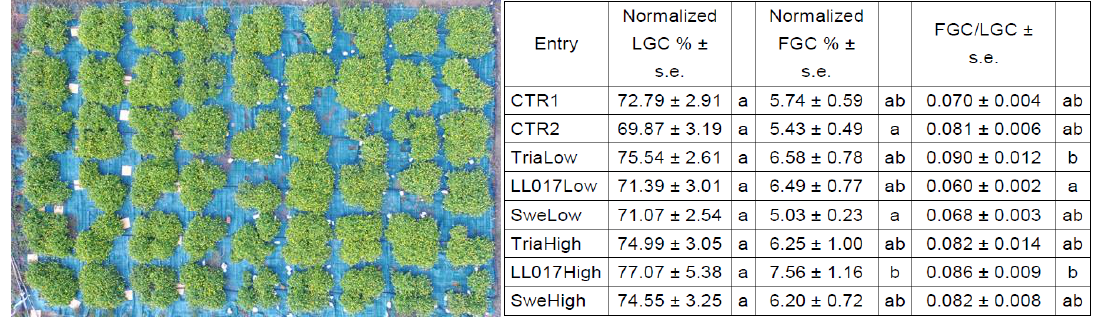
Figure 1. Plant dimension assessment on 08.10.18. Representative image of a drone picture (left) used for the determination of plant and flower quantification. Living ground cover (LGC), flower ground cover (FGC), and their ratio (right) resulting from the statistical analysis of numerical data obtained from the picture. The statistical analysis (software Statistica by StatSoft) was performed by means of one-way analysis of variance (one-way ANOVA) with Duncan Test (α) = 0.1. For each trait, at least one letter in common indicates no significant difference according to the Duncan test.